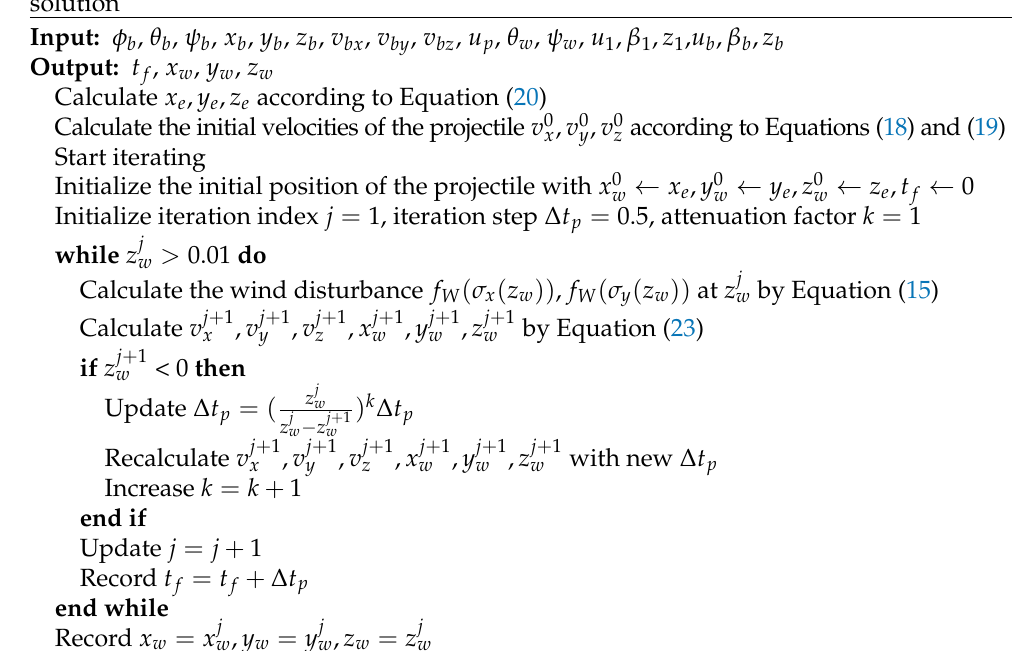
Algorithm 1 The one-way adaptive step velocity-verlet iterative algorithm of ballistic